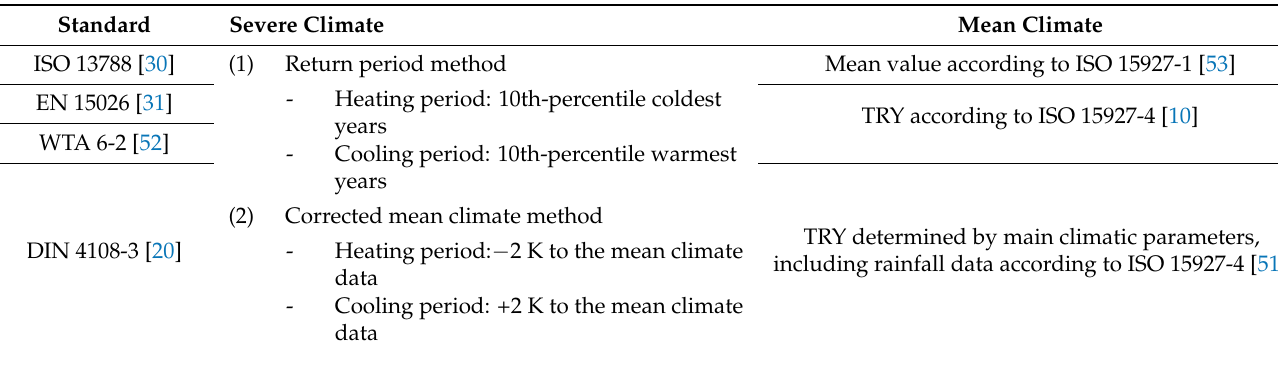
Table 5. Determination of the mean and the severe climate specified by